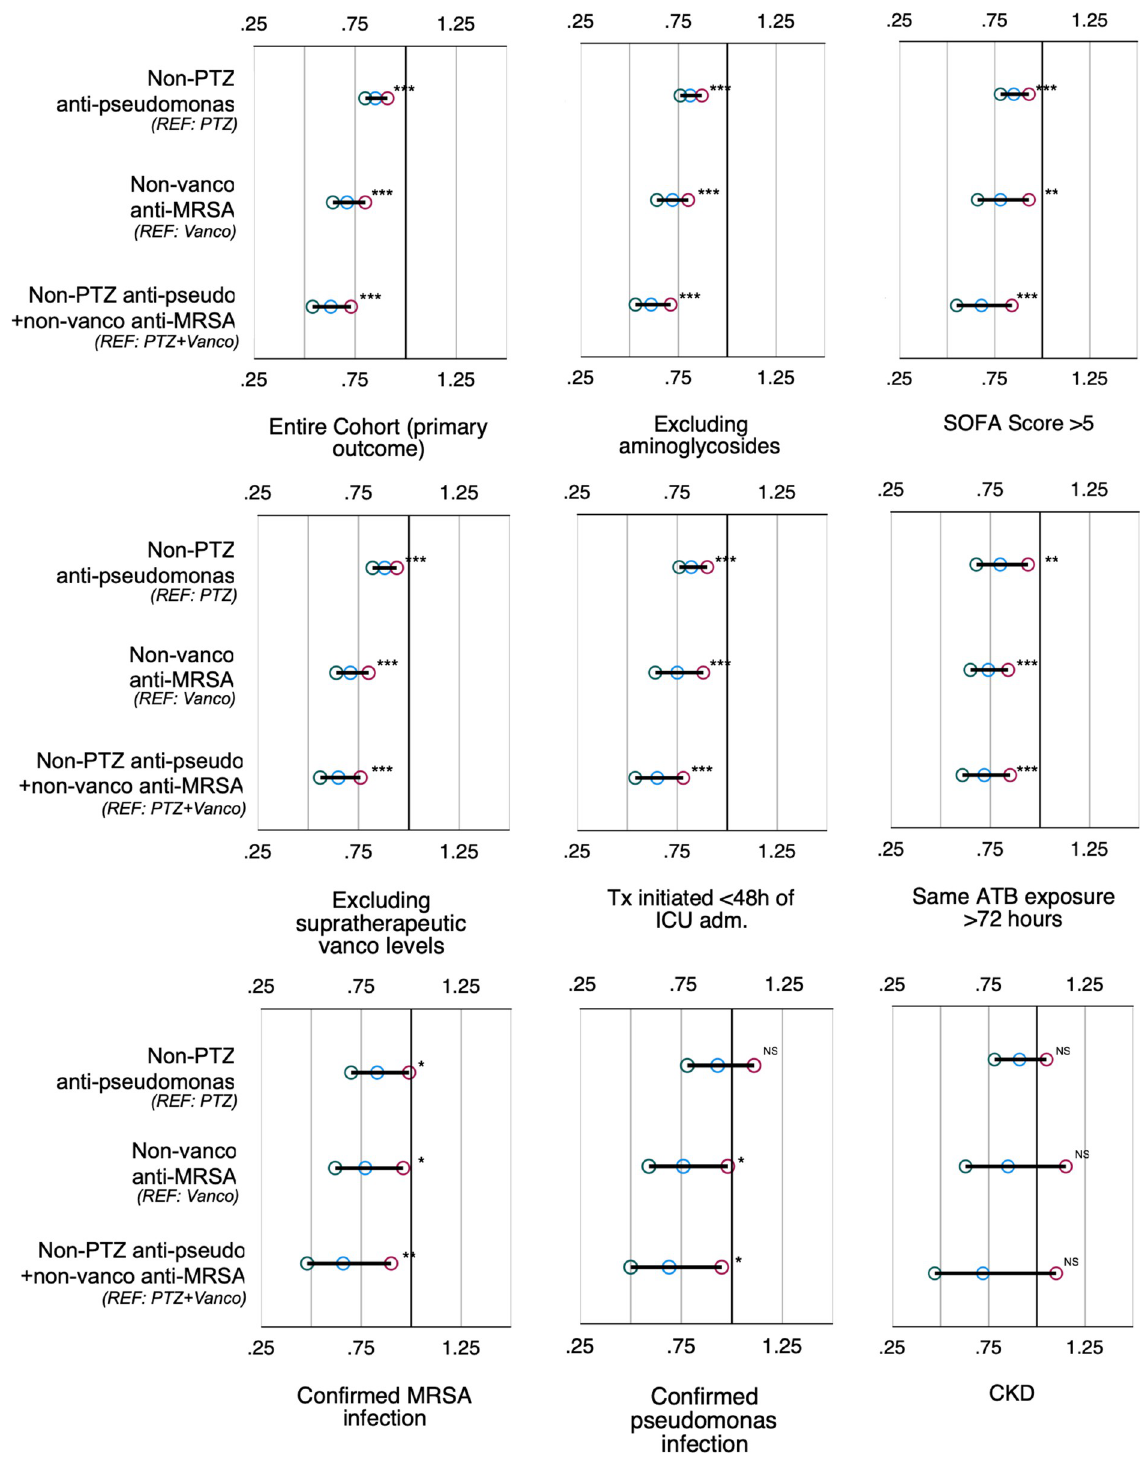
Fig 3. Forest plot of the association between exposure to anti-pseudomonas, anti-MRSA and their combination with new or worsening AKI within 7 days for the entire cohort and all subgroup analyses (multivariate). Results reported are Odds ratios with confidence intervals from a generalized estimating equation (binomial GEE) adjusted for: Age, sex, ethnicity, comorbidities (heart failure, liver disease and diabetes), SOFA score, hyperlactatemia, vasopressors, chronic kidney disease, antibiotic treatment duration, active bacteremia, positive ventilation, active corticosteroid therapy and leukopenia. Analyses for all anti-pseudomonal agents were also adjusted for the presence of a